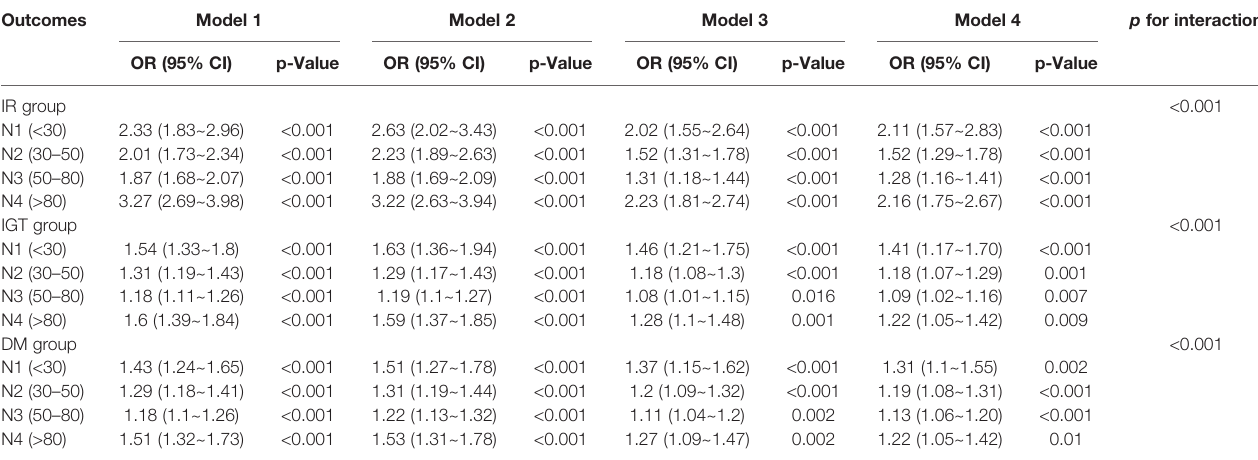
TABLE 3 | Multiple regression analysis of different VD3 levels.